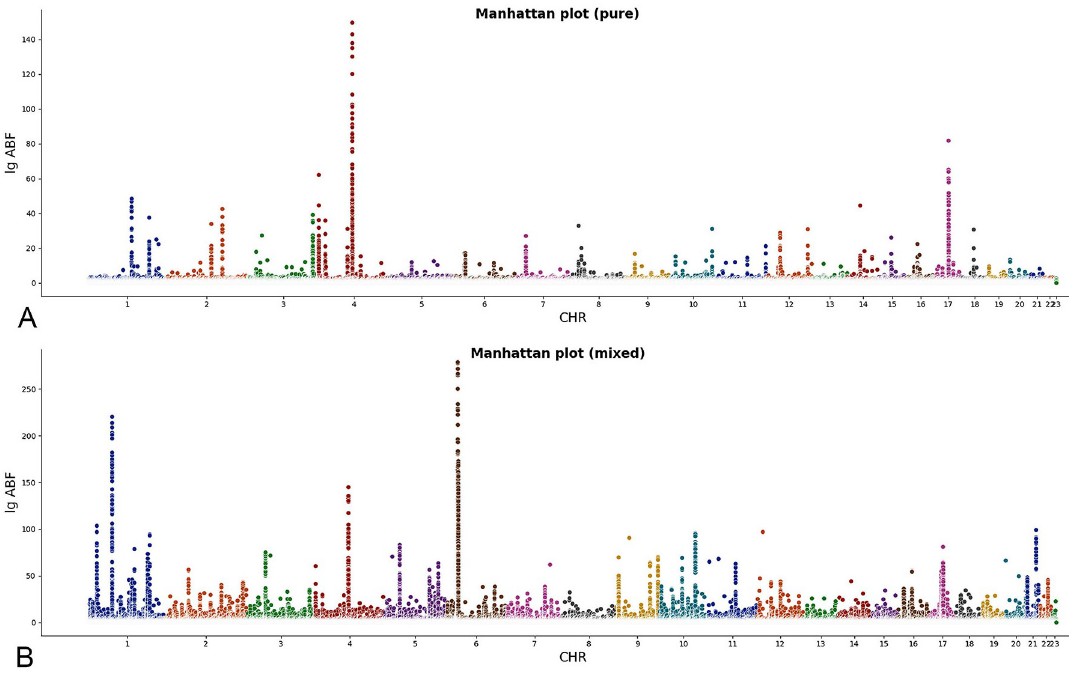
Fig 5. Manhattan plots. A. Results of pure meta-analysis, which includes 29 studies on PD. B. Results of mixed meta-analysis, which includes 59 studies on PD, inflammatory bowel disease (including its two subtypes: Crohn’s disease and ulcerative colitis), multiple sclerosis, and systemic sclerosis. lg ABF: log 10 ABF.